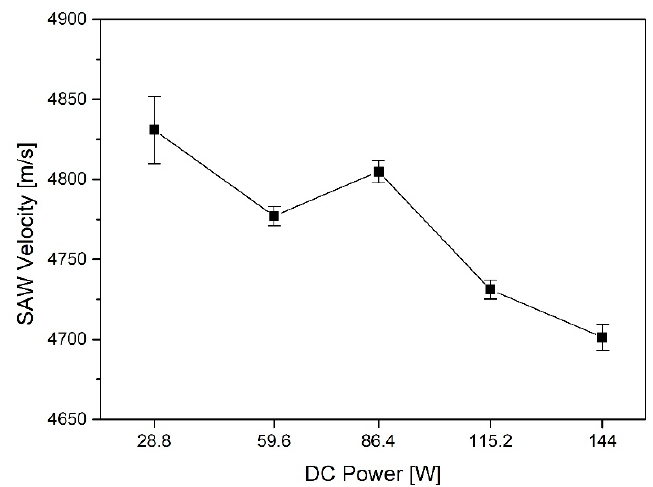
Figure 4. The results of SAW velocity using a scanning acoustic microscope (m/s).